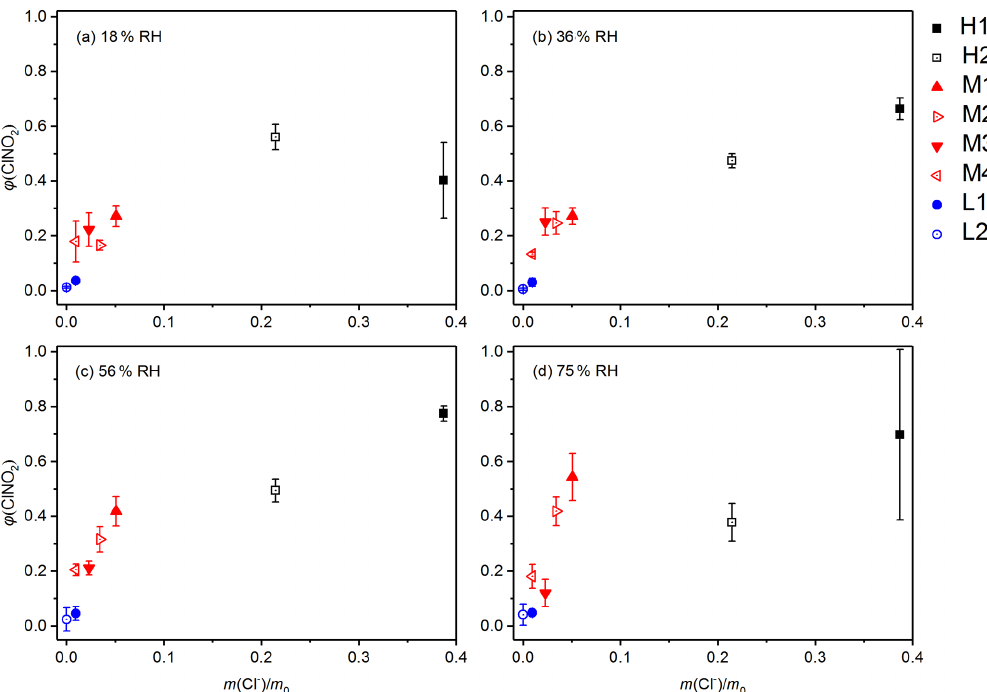
Figure 6. Dependence of ClNO 2 yields on mass fractions of chloride for the eight saline mineral dust samples at a given RH: (a) 18% RH,